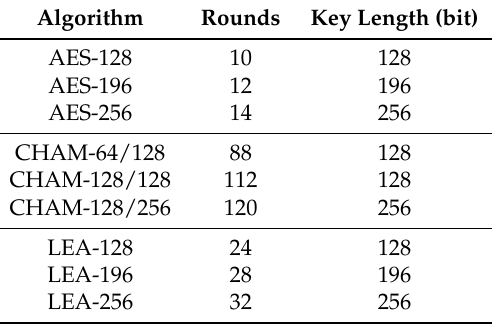
Table 3. Table of rounds according to key